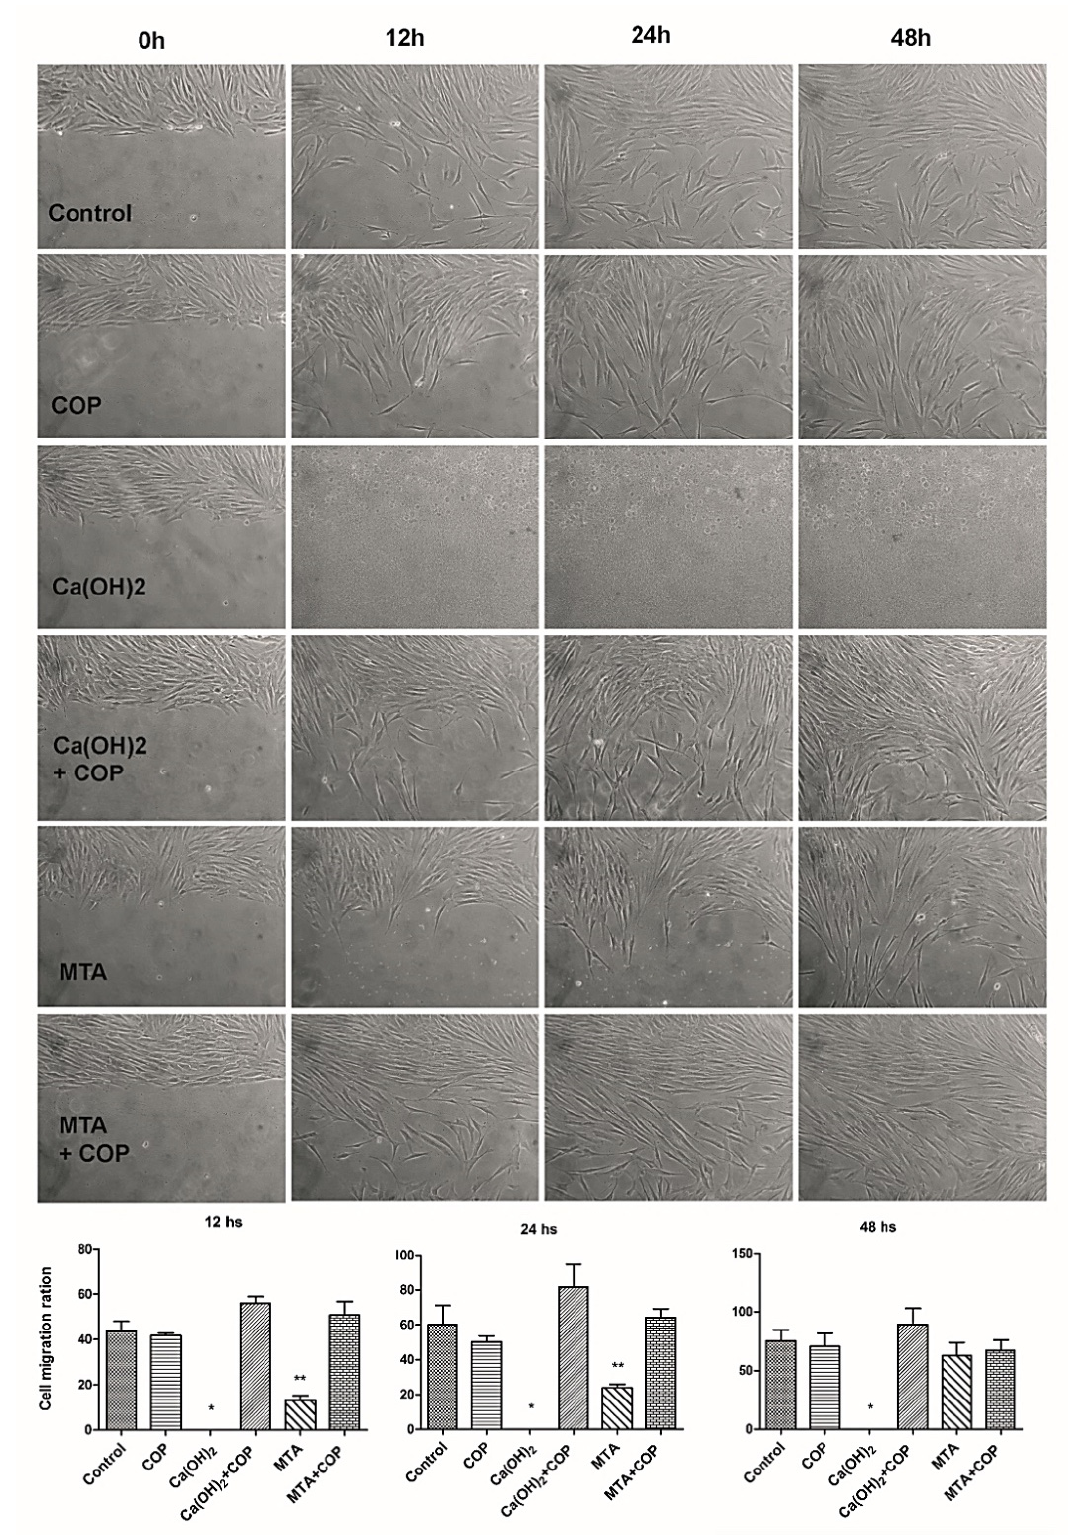
Figure 5. Representative phase microscopy images of cell migration for all the experimental groups over the duration of the experiment (original magnification 100 × ), along with a graphic representation of the mean cell density in the wound area per time point (cell migration ratio).* No migration was observed; ** significantly smaller than that observed in all the other groups ( p < 0.05), except for the Ca(OH)2 group at 24 h. Bars indicate the standard error of the mean.